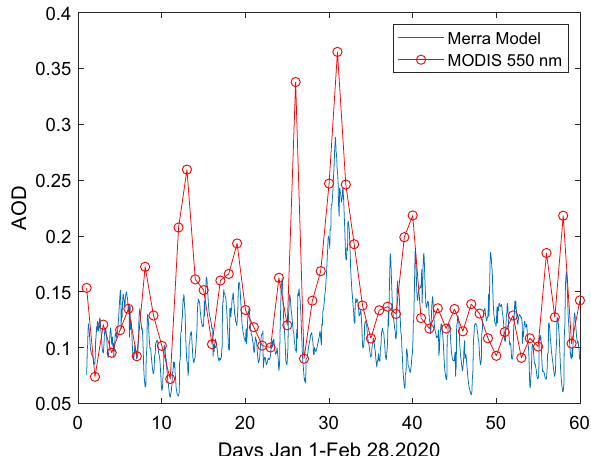
Figure 1. Merra-2 Model aerosol extinction at 550 nm and MODIS deep blue time series, area-averaged AOT 550 nm over Taals region (in areas of Longitudes:119°–123°, Latitudes